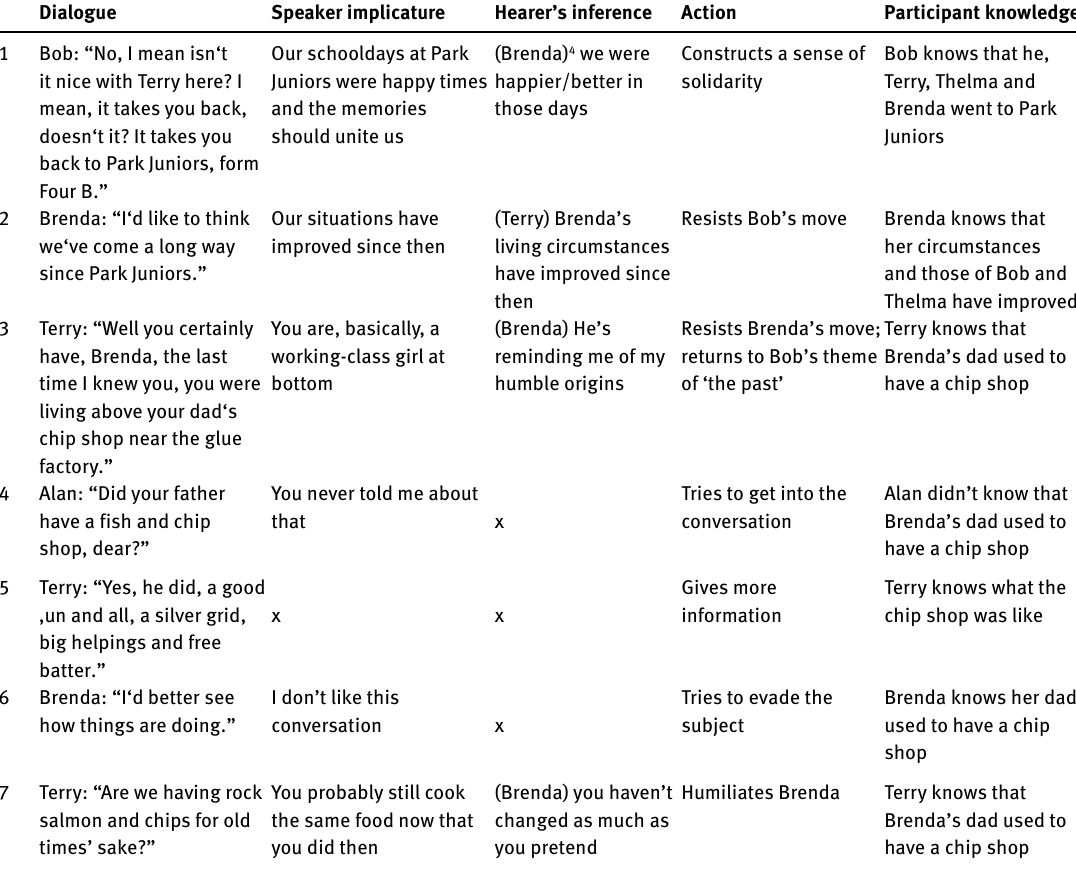
Table 3: ‘Guess who’s coming to dinner’, extract 34 Dialogue Speaker implicature Hearer’s inference Action Participant